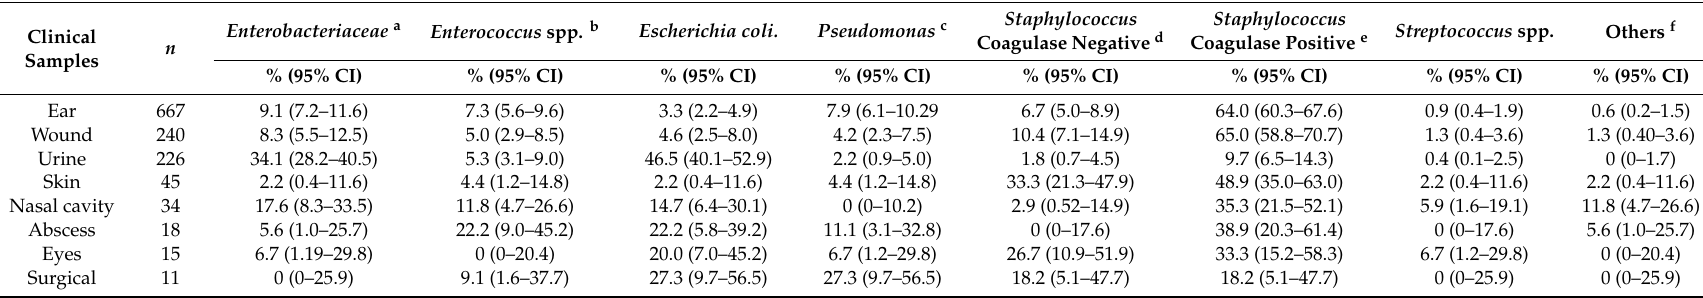
Table 1. Bacterial isolates from clinical samples from dogs submitted to the Diagnostic Laboratory of the Faculty of Agrarian Sciences, University of Antioquia (2016–2019).